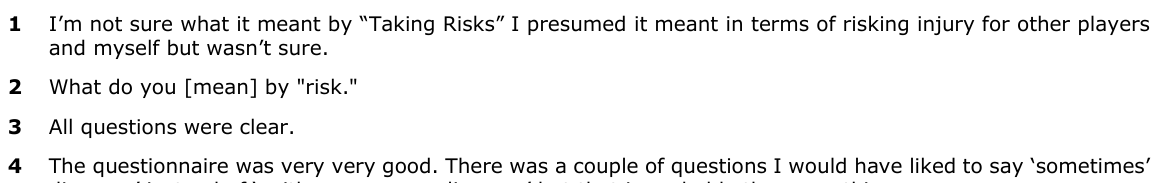
Table 12. Participants’ comments on the